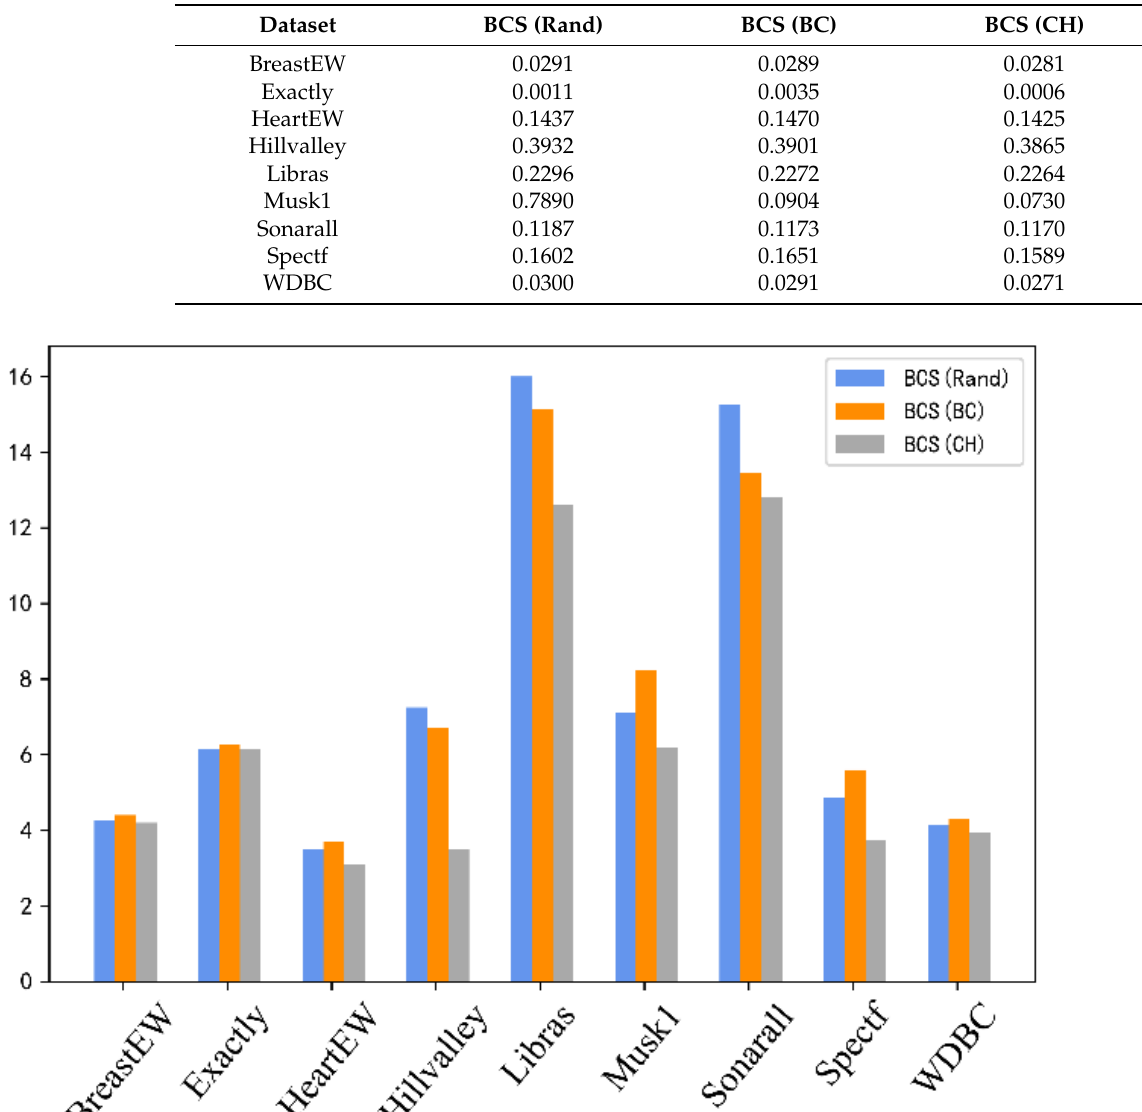
14 of 23 Table 2. Classification error rate of three initialization strategies. Dataset